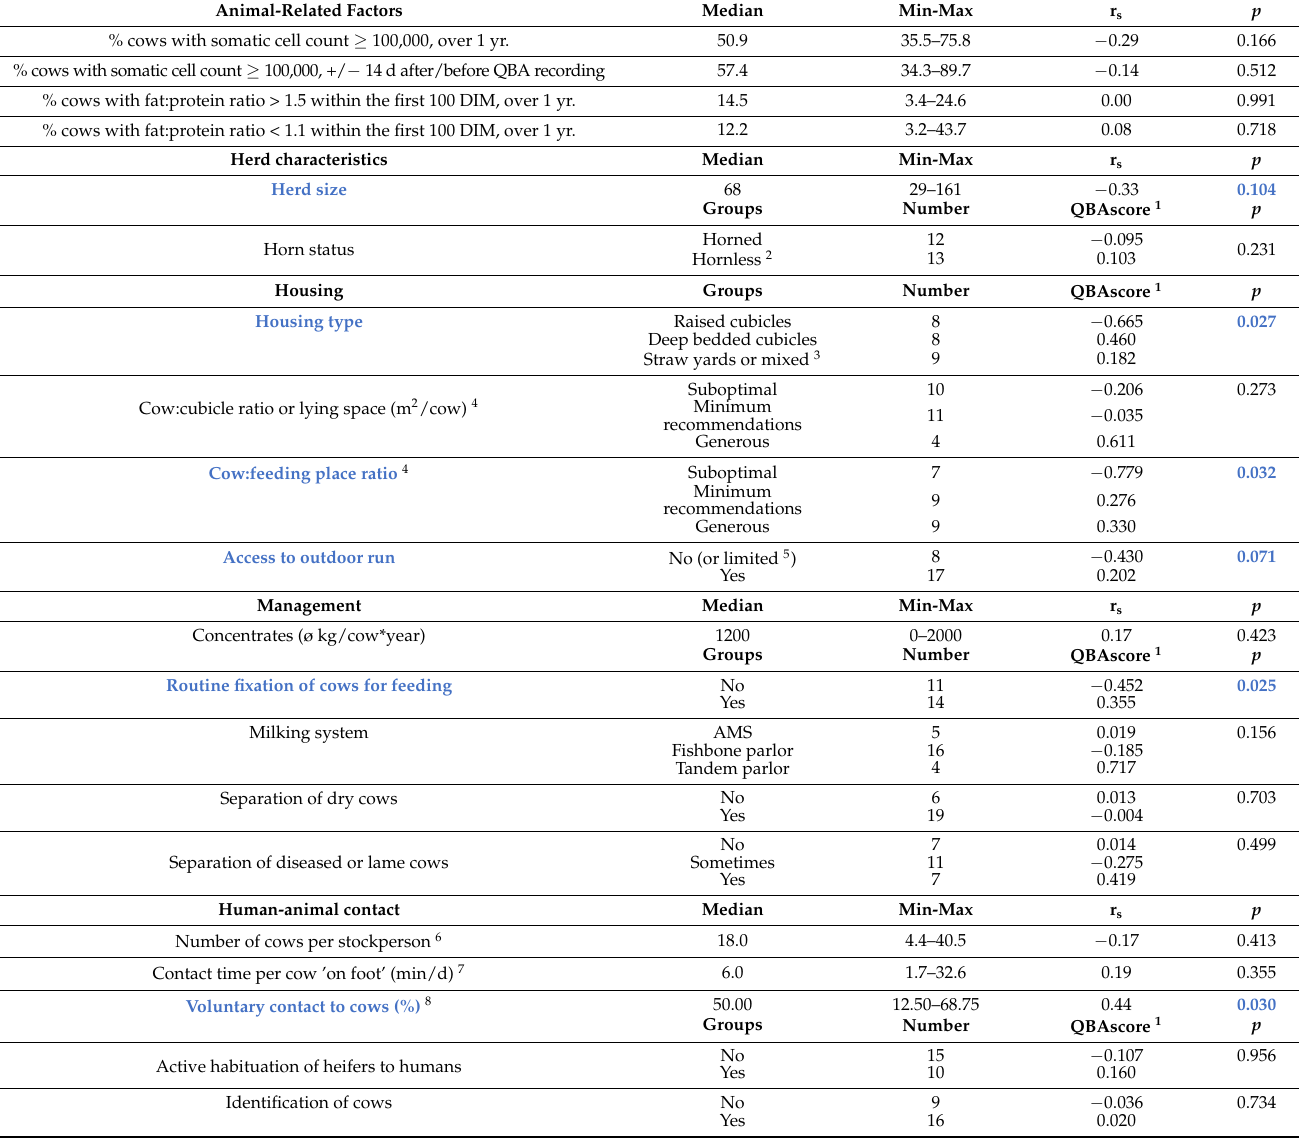
Table 1. Pre-selection of factors potentially affecting dairy herds’ behavior described by QBAscores 1 ; based on Spearman rank correlations (r s ) or group mean differences (Kruskal-Wallis/Mann-Whitney U test); factors selected for multivariable analysis ( p ≤ 0.1) are marked in blue ( n = 25). Animal-Related